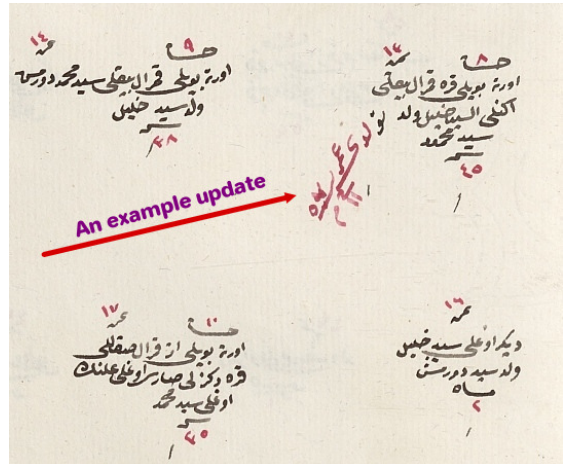
Figure 2. An example update drawn in red color is shown.